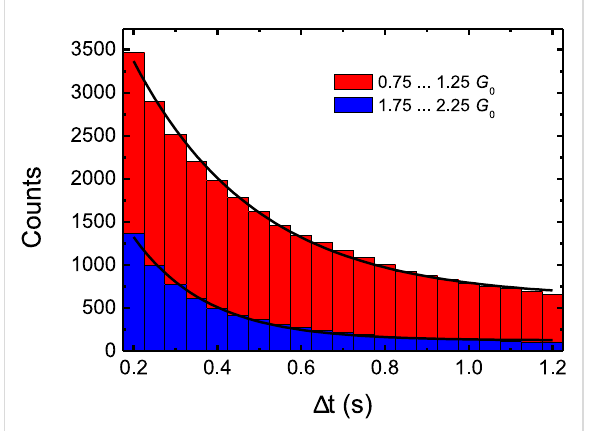
Figure 2: Number of conductance levels with level length greater than Δ t as a function of Δ t . The plot is given for two conductance levels: For the conductance range of 1 G 0 ± 0.25 G 0 and for the conductance range of 2 G 0 ± 0.25 G 0 taken from the histogram of Figure 1. By fitting an exponential decay function (solid lines) in the period between 0.2 s and 1.2 s, an average lifetime of the maximum at 1 G 0 was estimated as τ 1 ≈ 0.29 s and at 2 G 0 as τ 2 ≈ 0.18 s. Full results of the lifetimes analysis are found in Table 1.